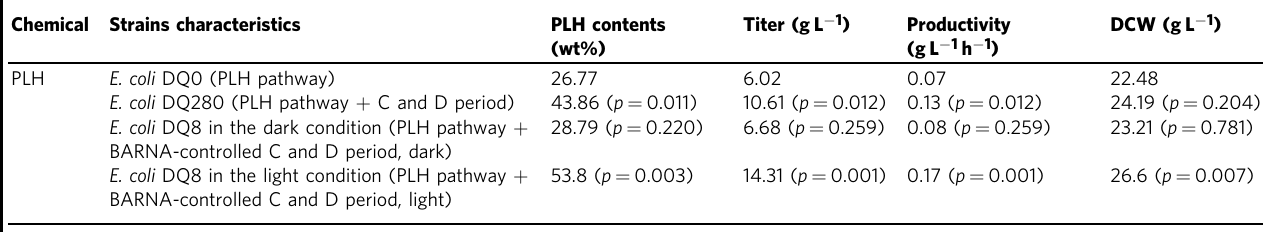
Table 2 Differences in wild type and engineered E. coli on PLH production in 5 L fermenter. Chemical Strains